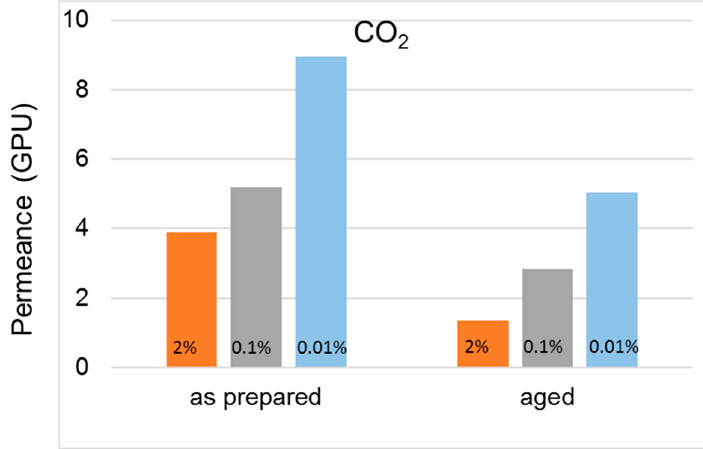
Figure 7. Change in CO 2 permeance over time in cross-linked HF membranes (T3-type) prepared with different EDA concentrations in the bore fluid.